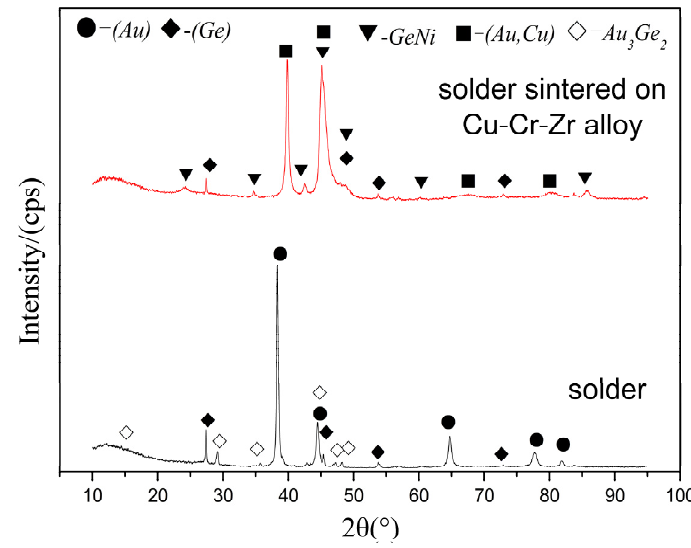
Figure 5. X-ray diffractometer (XRD) patterns of the solder and the solder sintered on Cu-Cr-Zr alloy.